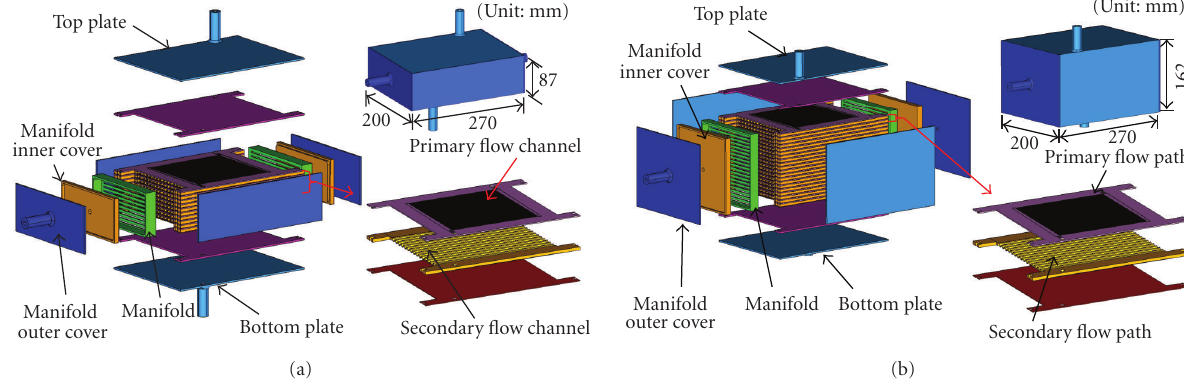
Figure 2: Overall dimension and parts of the plate-type PHE prototypes: (a) 3 kW class PHE prototype and (b) 10kW class PHE prototype.